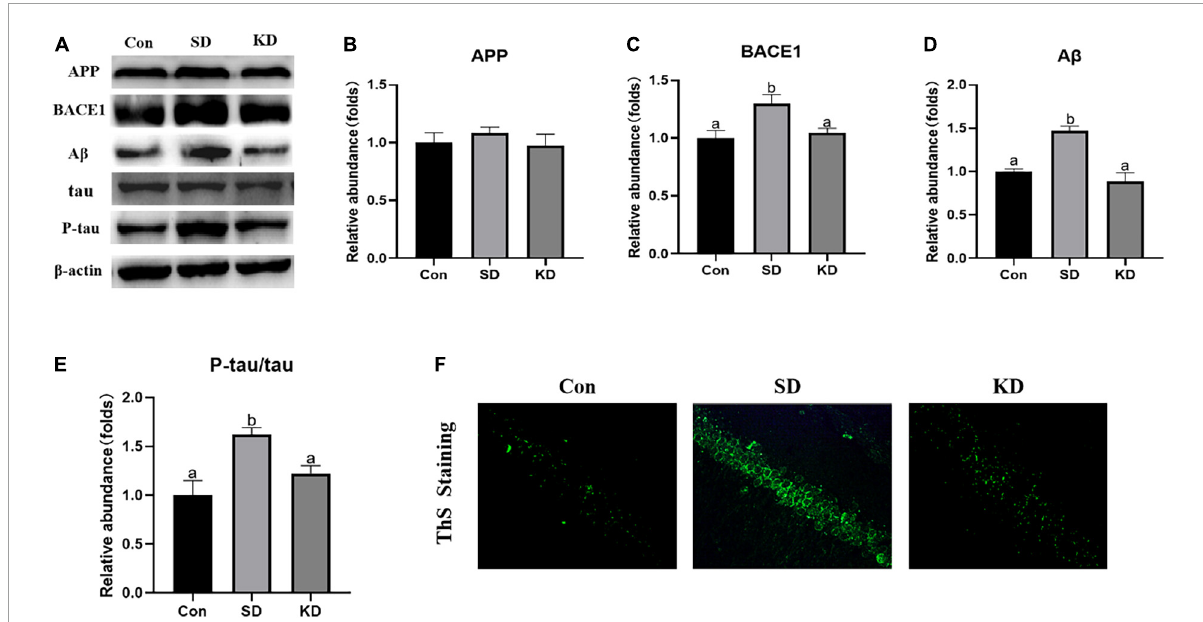
FIGURE3 Effects of ketogenic diet (KD) on A β deposition and tau phosphorylation in the chronic sleep deprivation (SD) exposed mice. (A) Western-blots and (B–E) densitometry of APP, BACE1, A β , and p-tau/tau. Protein levels are normalized to β -actin which served as loading control and reproduced with Sham group. Values are indicated as the mean ± SEM ( n = 7). Different letter indicates significantly different between each group ( p < 0.05). (F) ThS staining in the hippocampus, scale bars = 50 µ m ( n =